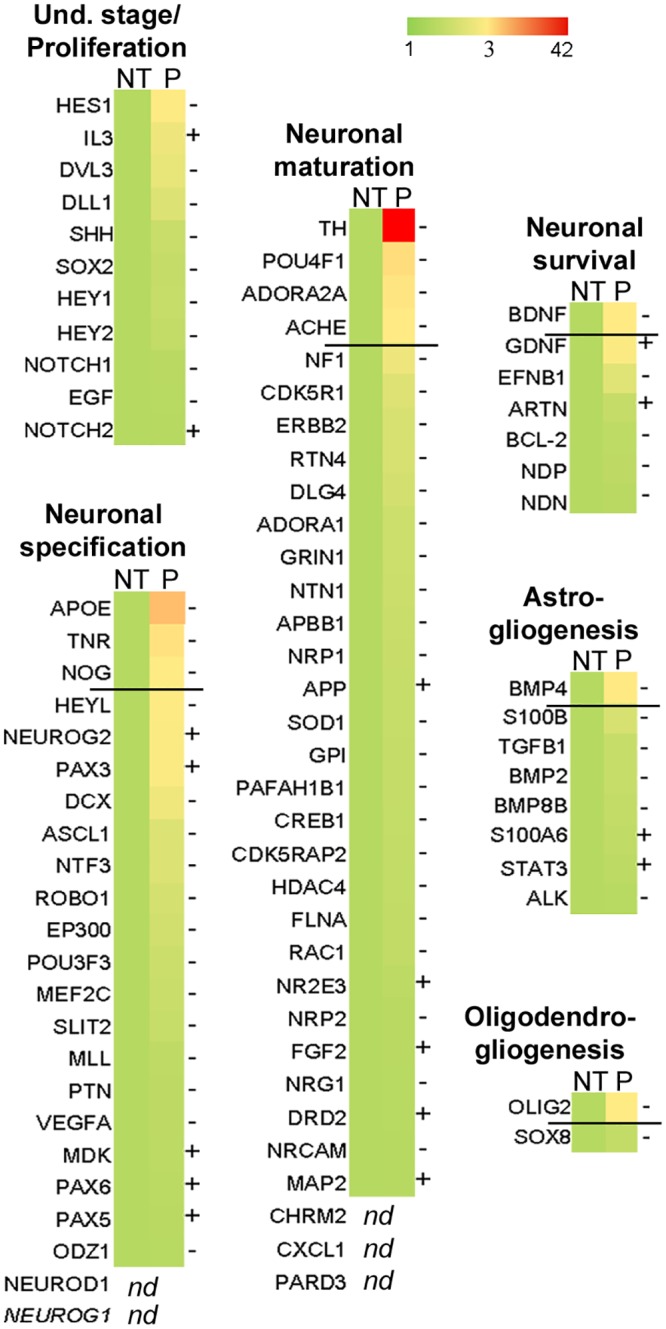

bdv-p alters the molecular program involved in neurogenesis.
bdv-p-expressing-hNPCs and their matched NT controls were induced to differentiate for 4 days and RNA was analyzed using an RT-PCR array. The 84 human genes analyzed are shown. A color code shows the differential expression of the genes, from green (non-regulated) to red (the most regulated). Genes were grouped depending on their known function in neurogenesis. Up to the dark line are the genes significantly modified after application of an arbitrary cut-off of 3. -, genes down-regulated. +, genes up-regulated.